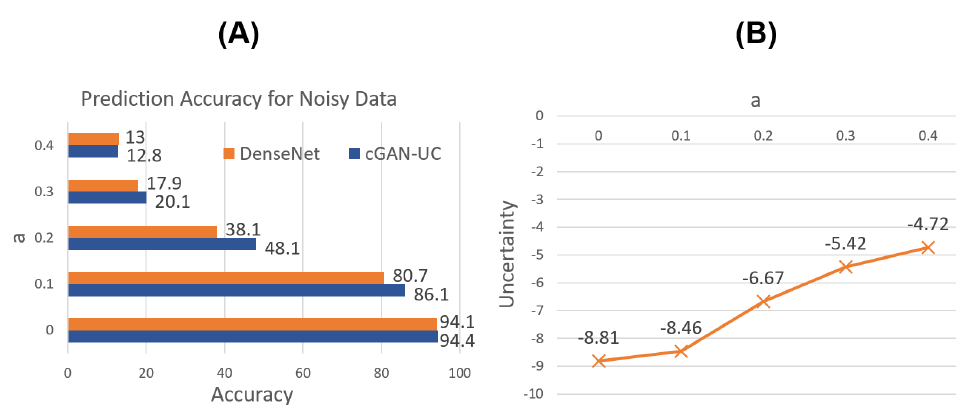
Figure 6. Prediction results for noisy test set of CIFAR-10. ( A ) Prediction accuracy of DenseNet and cGAN-UC with respect to noise. ( B ) The proposed uncertainty measure in cGAN-UC with respect to noise.